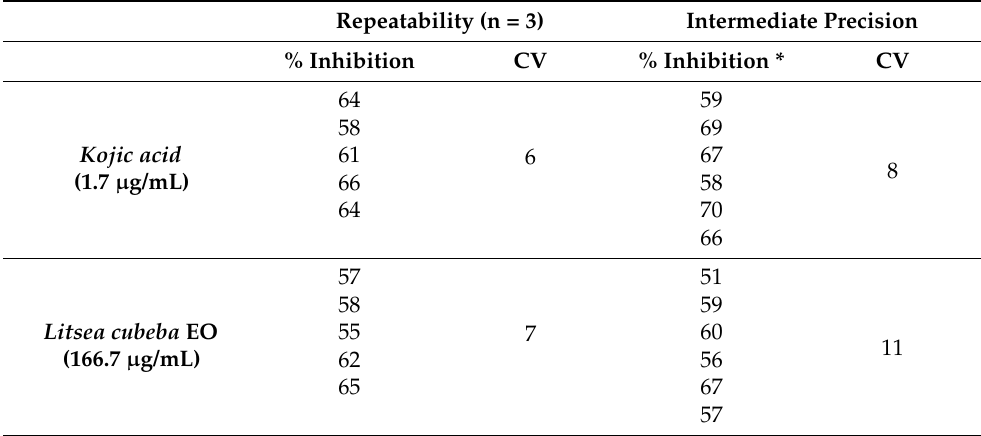
Table 4. Data precision expressed as CV for both repeatability (n = 5) and intermediate precision (n = 6). * Values represent the average of three assays. Repeatability (n =